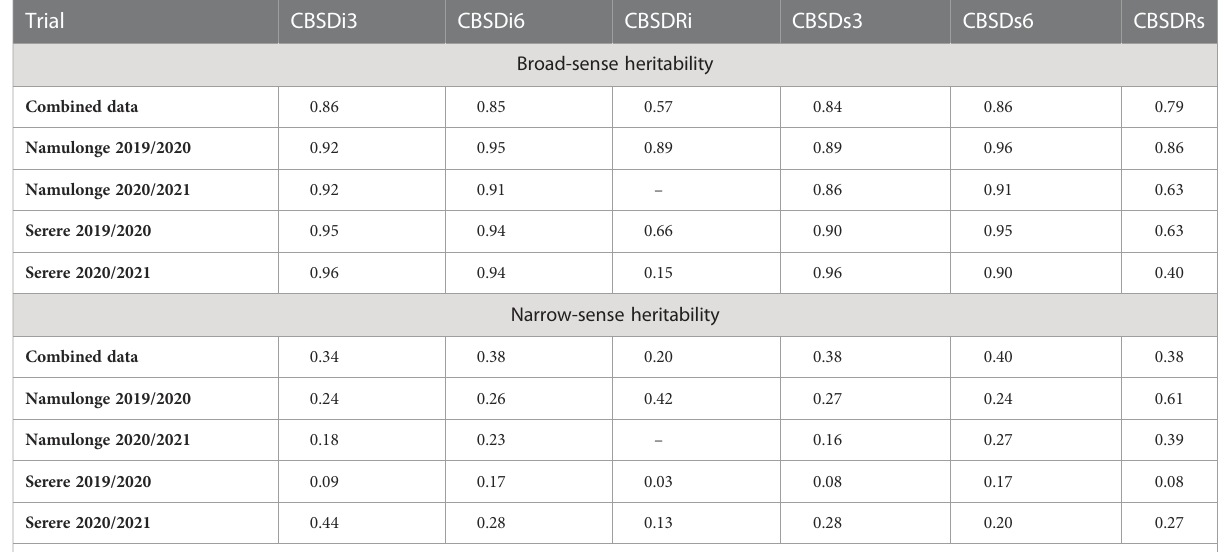
TABLE 4 Broad sense heritability of two clonal evaluation trials evaluated at Namulonge and Serere in 2019/2020 and 2020/2021 season.